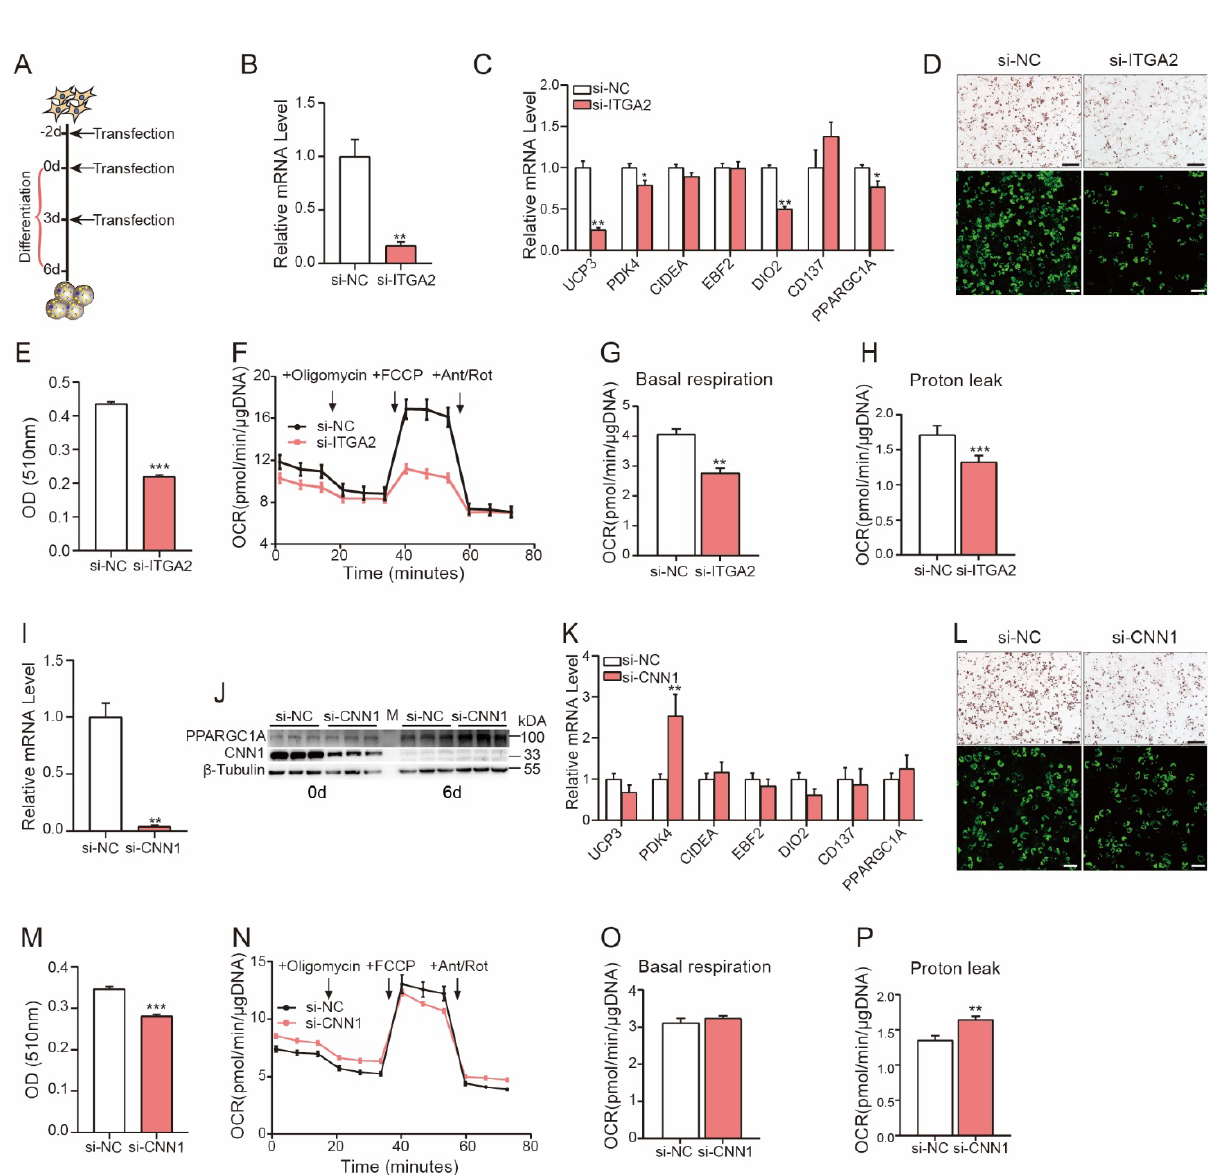
Figure 5. ITAG2 and CNN1 are involved in porcine beige adipocyte differentiation and thermogenesis. ( A ) Schematic of si-ITGA2 or si-CNN1 treatment during adipogenic induction. ( B ) The knockdown efficiency of si-ITGA2 was examined by qPCR on day 6. ( C ) Expression of beige adipocyte markers in cells transfected with si-ITGA2. ( D ) Effect of si-ITGA2 transfection on beige adipogenesis, as determined by Oil Red-O staining (top, scale bar is 200 μm) and fluorescence staining (bottom, scale bar is 100 μm) on day 6. ( E ). Quantitative analysis of the Oil Red-O staining data shown in D via OD measurements. F-H. OCR in differentiated porcine beige adipocytes transfected with si-NC or si-ITGA2 ( F ); the basal cellular respiration rate ( G ) and proton leak ( H ) were calculated ( n = 10). ( I , J ) The knockdown efficiency of si-CNN1 was examined by qPCR and Western blotting on day 6. ( K ). Expression of beige adipocyte markers in cells transfected with si-CNN1. ( L ). Effect of si-CNN1 transfection on beige adipogenesis, as determined by Oil Red-O staining (top, scale bar is 200 μm) and fluorescence staining (bottom, scale bar is 100 μm) on day 6. ( M ). Quantitative analysis of the Oil Red-O staining data shown in L via OD measurements. ( N – P ) OCR in differentiated porcine beige adipocytes transfected with si-NC or si-CNN1 ( N ); the basal cellular respiration rate ( O ) and proton leak ( P ) were calculated ( n = 10). The Seahorse assay data were normalized to the total DNA content. All data are shown as the mean ± SEM. P values were calculated by the unpaired two-tailed Student’s t test. * p < 0.05, ** p < 0.01, *** p < 0.001.